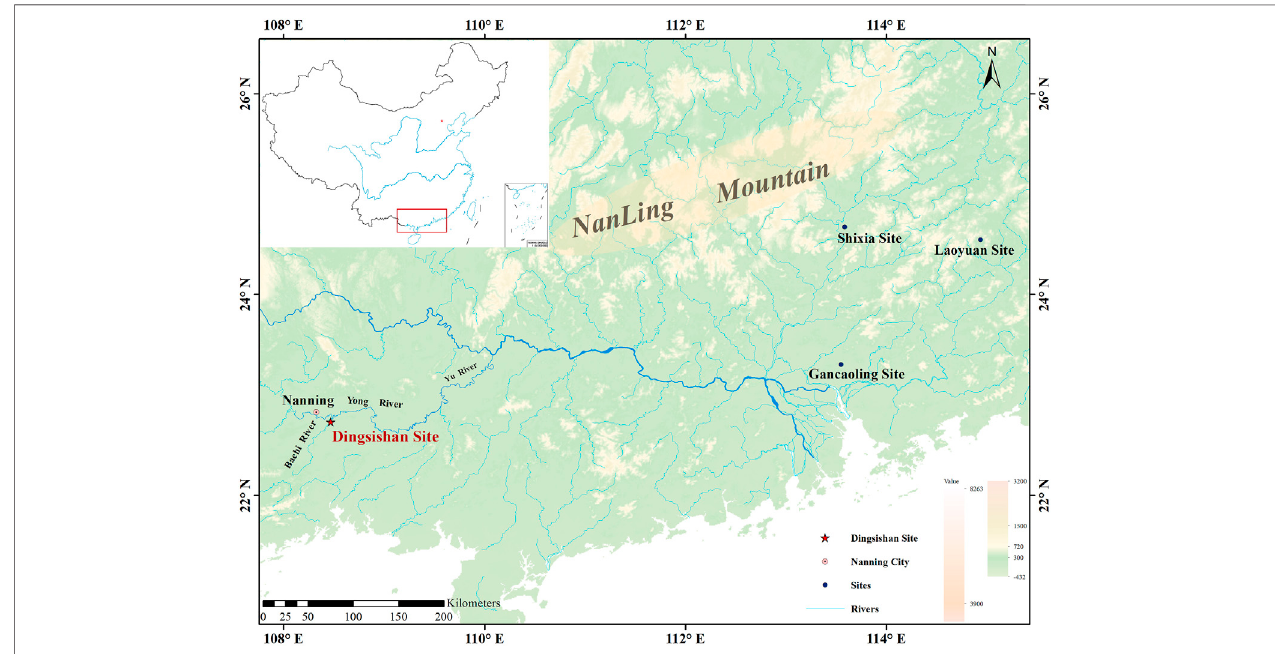
FIGURE 1 | Geographic location of the Dingsishan site and other Neolithic Site mentioned in this paper.